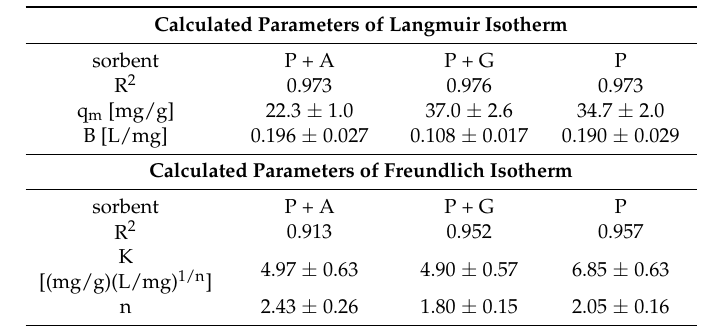
Table 2. Calculated parameters of isotherms, Langmuir and Freundlich, of Zn(II) ions sorption on pectin-based biosorbents (P + A—hybrid pectin biosorbent with agar, P + G—hybrid pectin biosorbent with guar gum, P—sole pectin